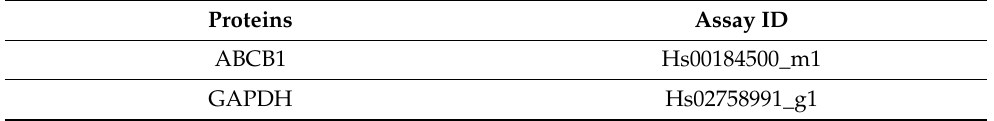
Table A2. TaqMan assays for qRT-PCR analyses with the LightCycler